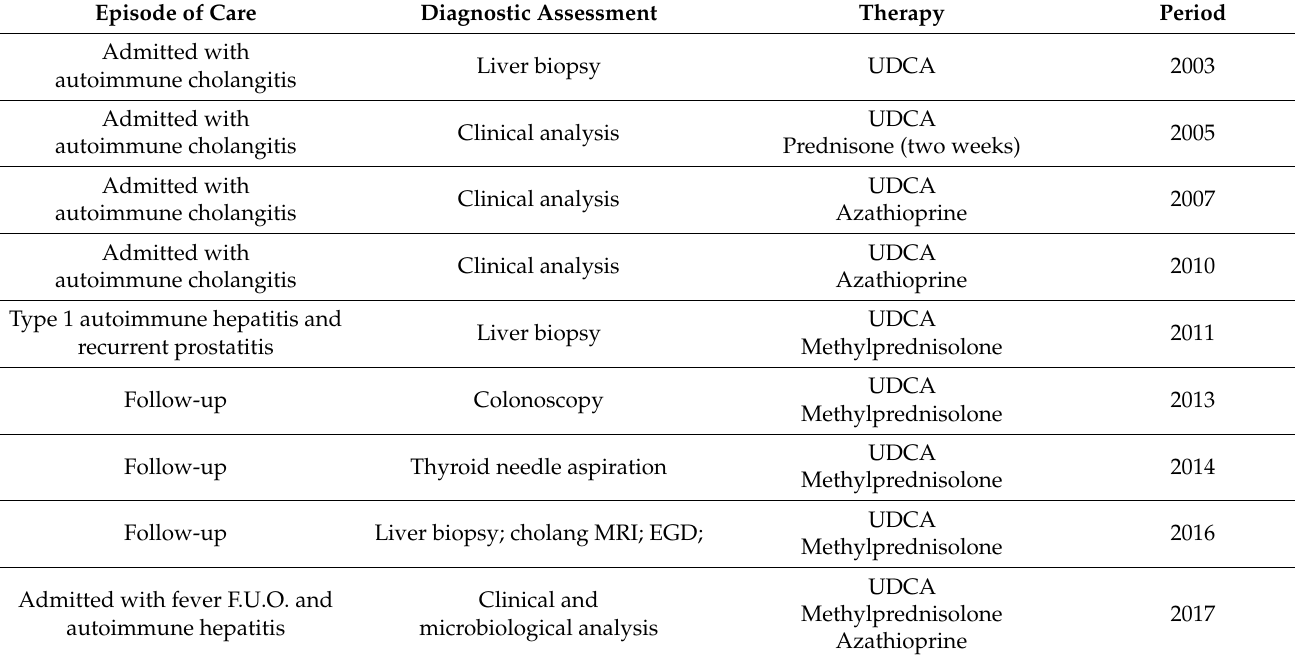
Table 1. Timeline of relevant data from the episode of